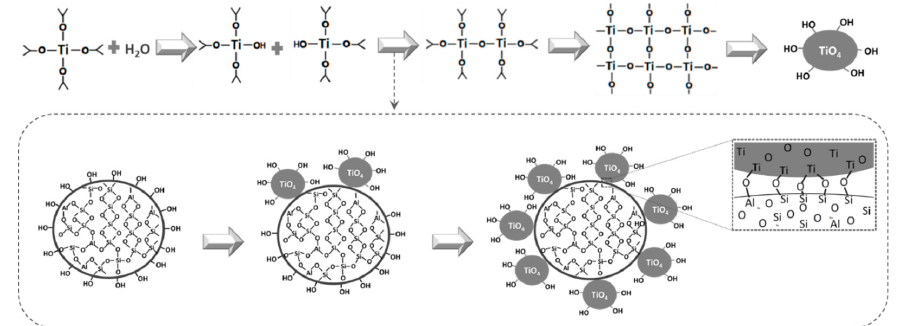
Figure 4. X-ray diffraction (XRD) pattern of ( a ) rice hull ash (RHA), ( b ) fly ash (FA), ( c ) geopolymer (GP), ( d ) titania (TiO 2 ) and ( e ) TiO 2 -coated GP sphere (GP + TiO 2 ). 1—quartz; 2—magnetite; 3—